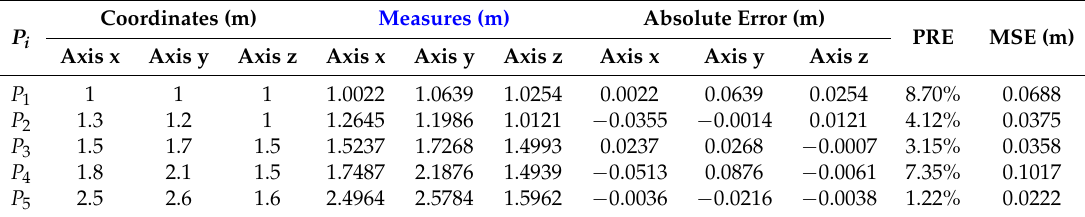
Table 3. Experimental measures of positions with calibrated